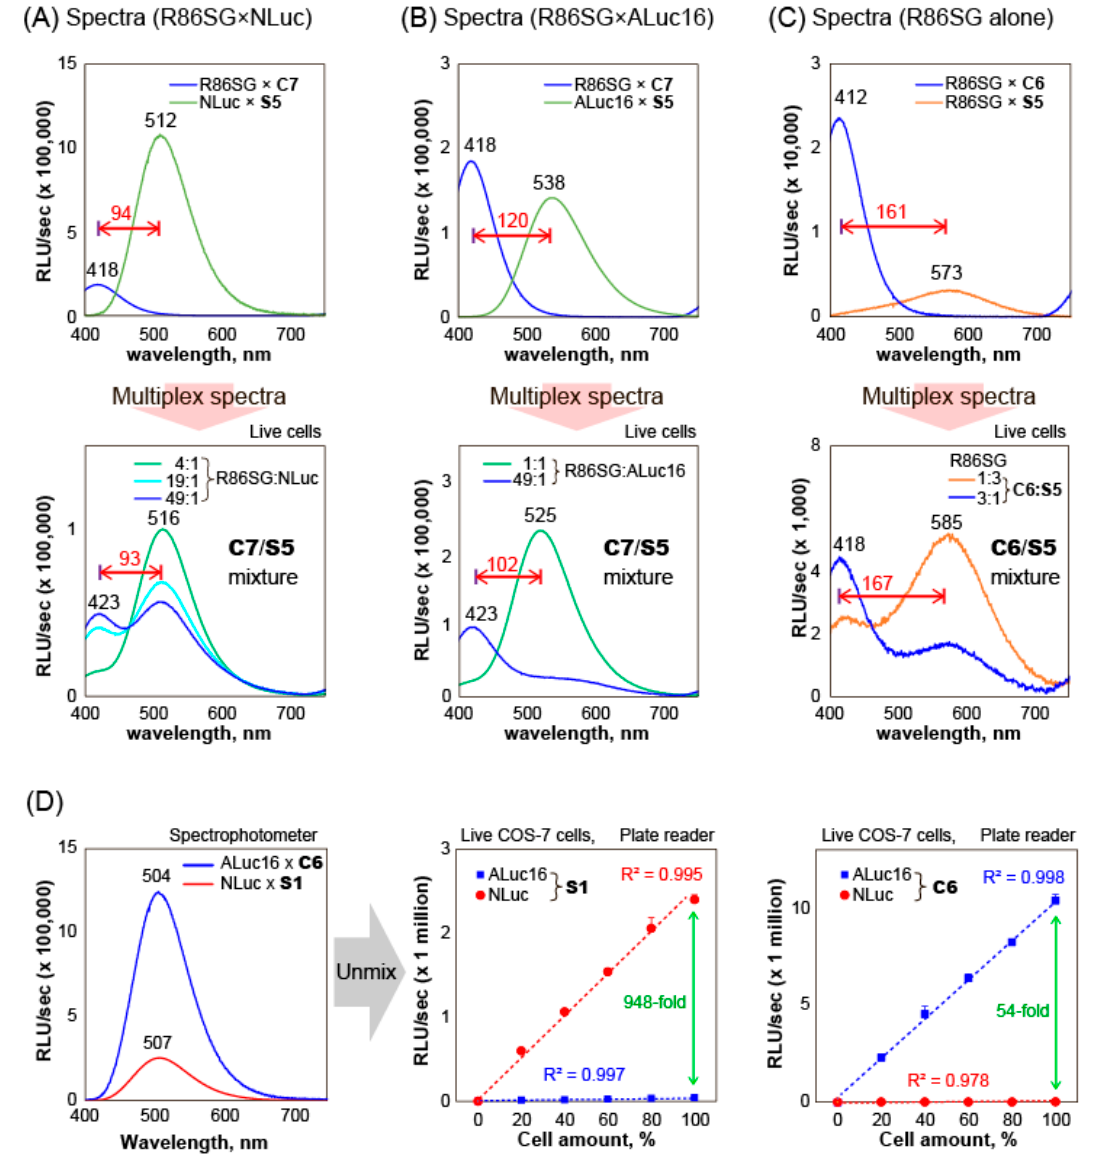
Figure 4. Separation of the BL signals in multiplex reporter systems ( A ) The BL spectra of multiple reporter systems consisting of R86SG and NLuc. The BL spectra were developed by C7 and S5 . The upper panel shows respective BL spectra of R86SG and NLuc, and the bottom panel demonstrates the BL spectra of the mixtures of R86SG- and NLuc-containing cells in different ratios. ( B ) The BL spectra of multiple reporter systems consisting of R86SG and ALuc16. The BL spectra were developed by C7 and S5 . The upper panel shows respective BL spectra of R86SG and ALuc16, and the bottom panel demonstrates the BL spectra of the mixtures of R86SG- and ALuc16-containing cells in different ratios. ( C ) The BL spectral variation of R86SG according to the substrates, C6 and S5 . The upper panel shows respective BL spectra of R86SG with C6 and S5 , and the bottom panel demonstrates the BL spectra of R86SG-containing cells that were developed by the mixture of C6 and S5 . ( D ) Separation of the BL signals of ALuc16 and NLuc based on the specificity of C6 and S1 . The left panel is the BL spectra of ALuc16 and NLuc in the presence of C6 and S1 . The left panel reveals that the spectra have completely superimposed each other. The middle and right panels indicate the quantitative feature of the BL signals of COS-7 cells NLuc or ALuc16 in the presence of an access level of C6 or S1 . The CTZ analogues C6 and S1 selectively luminesce with NLuc and ALuc16,